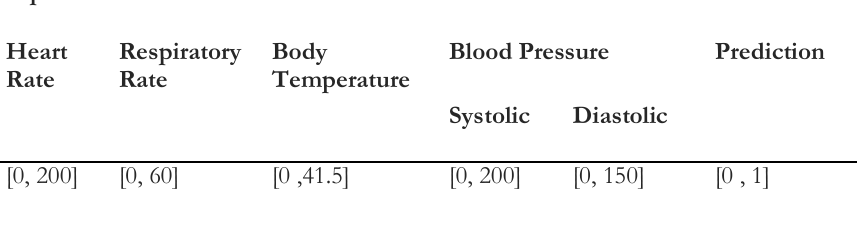
Table 2. The input variables and the universe of